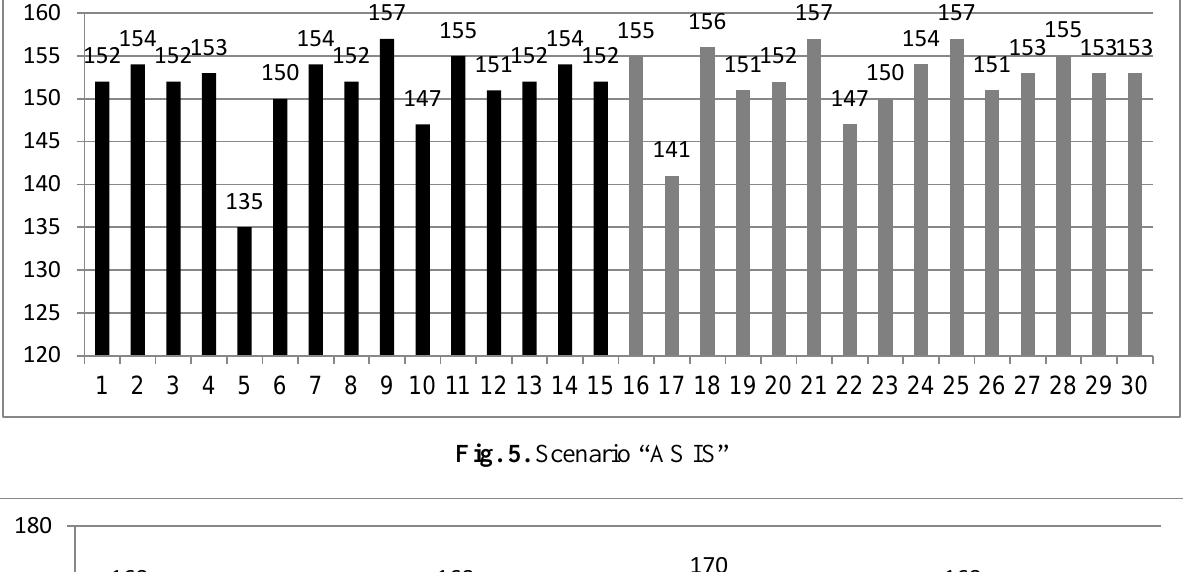
Fig. 5. Scenario “AS IS”